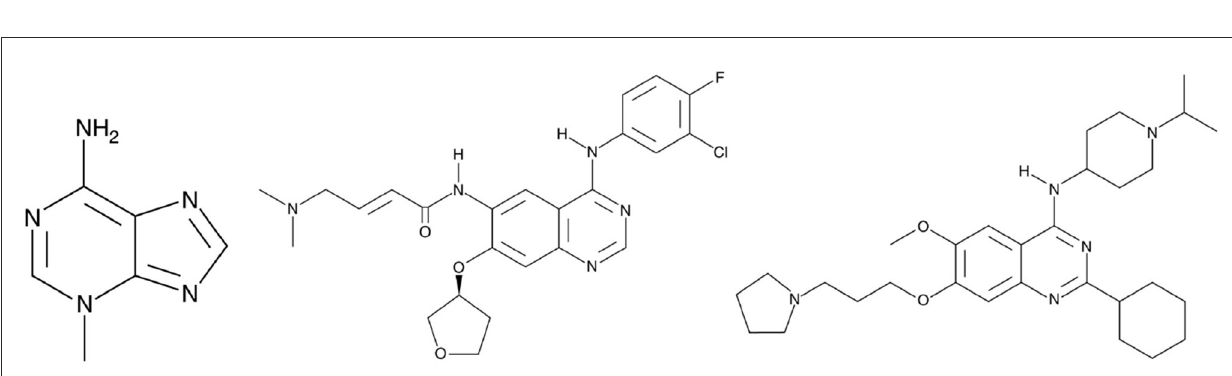
FIGURE7 From left to right is 3-Methyladenine, Afatinib and UNC-0638, respectively. 3-Methyladenine was not accurately predicted while the other two compounds obtained accurate prediction of their activity in TNBC.